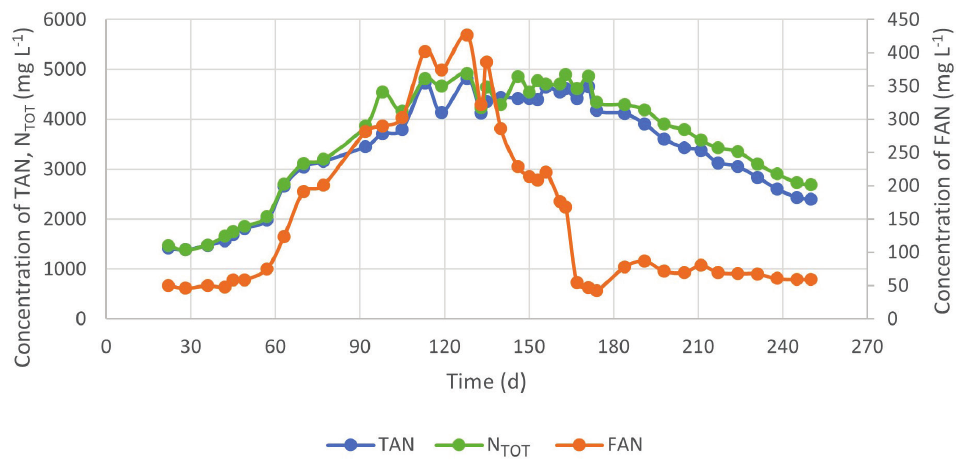
Fig. 4 – Concentration of total nitrogen (N